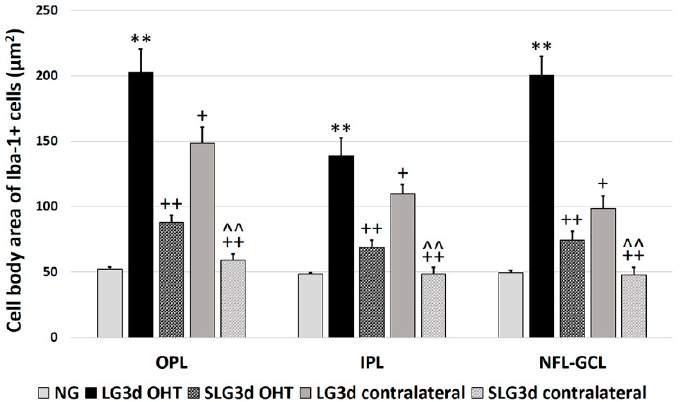
Figure 8. Cell body area of Iba-1 + cells in the outer plexiform layer (OPL), inner plexiform layer (IPL), and nerve fiber—ganglion cell layer (NFL-GCL) in eyes untreated and treated with saffron extract at day 3 after ocular hypertension (OHT) induction. Histograms show the mean cell body area ( ± standard deviation, SD) of Iba-1 + cells. Abbreviations: Naïve age-matched control (NG), lasered group contralateral (LG3d contralateral), lasered group ocular hypertension (LG3d OHT), lasered group contralateral + saffron (SLG3d contralateral), lasered group ocular hypertension + saffron (SLG3d OHT). Statistical significance indicators: ** p < 0.01; vs. NG. + p < 0.05, ++ p < 0.01 vs. LG3d OHT. ˆˆ p < 0.01; vs. LG3d